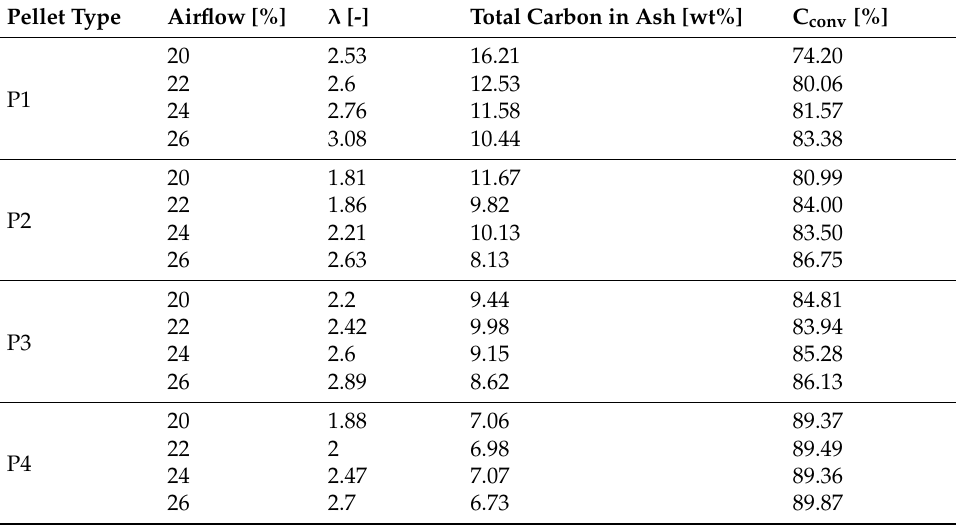
Table 4. Combustion efficiency represented by carbon conversion.